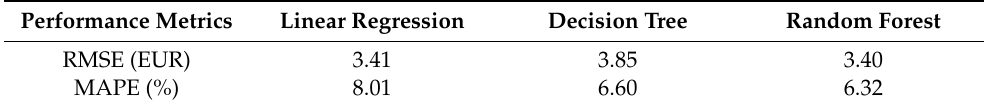
Table 4. Comparison of performance metrics of the models. Performance Metrics